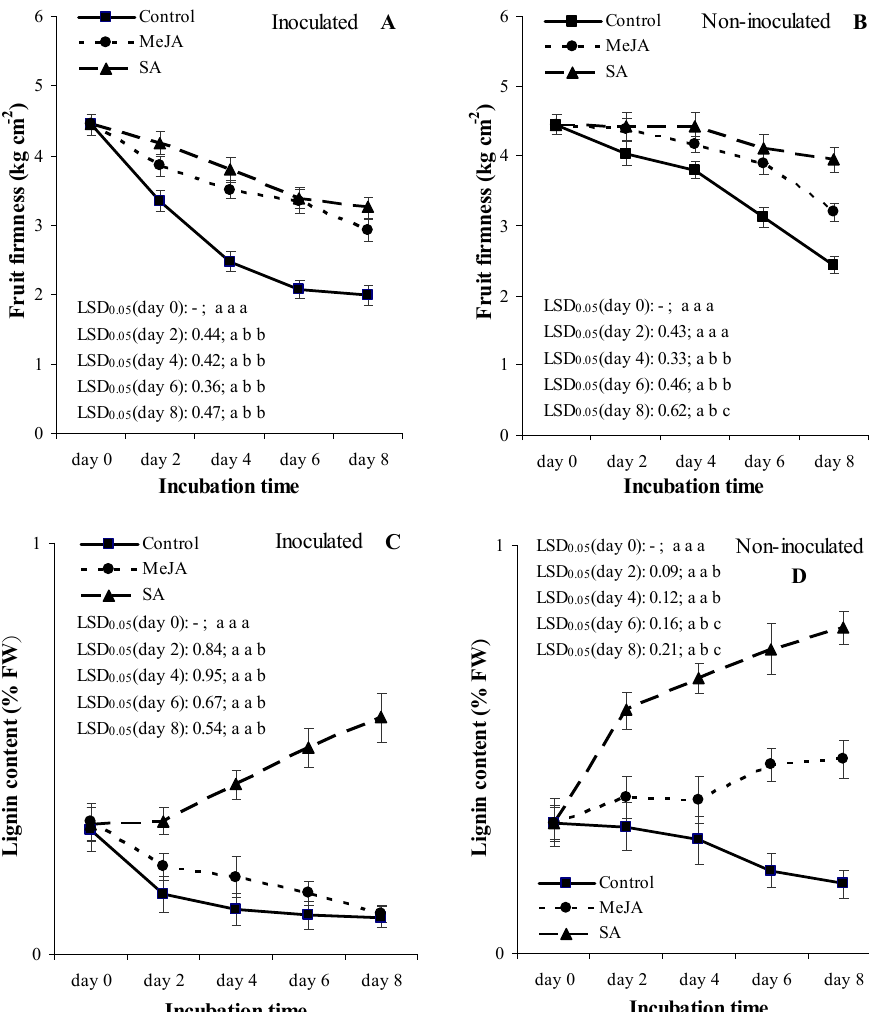
Figure 2. Effect of 2 mmol L − 1 salicylic acid (SA) and 0.4 mmol L − 1 methyl jasmonate (MeJA) on fruit firmness (kg cm − 2 ) ( A , B ) and on lignin content (% FW) ( C , D ) of apricot fruit (cultivar ‘Bergarouge’) in treatments of inoculated with Monilinia laxa ( A , C ) and non-inoculated ( B , D ) fruits assessed at days 0, 2, 4, 6 and 8 after treatment began. Information on symbols, error bars and letters for LSD 0.05 values is presented in Figure 1.